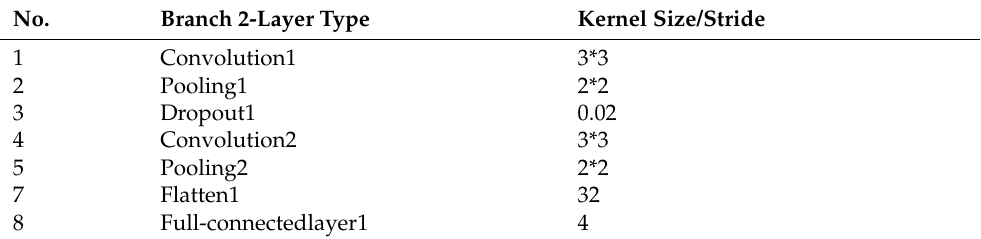
Table 2. The parameter information for the discriminative model.